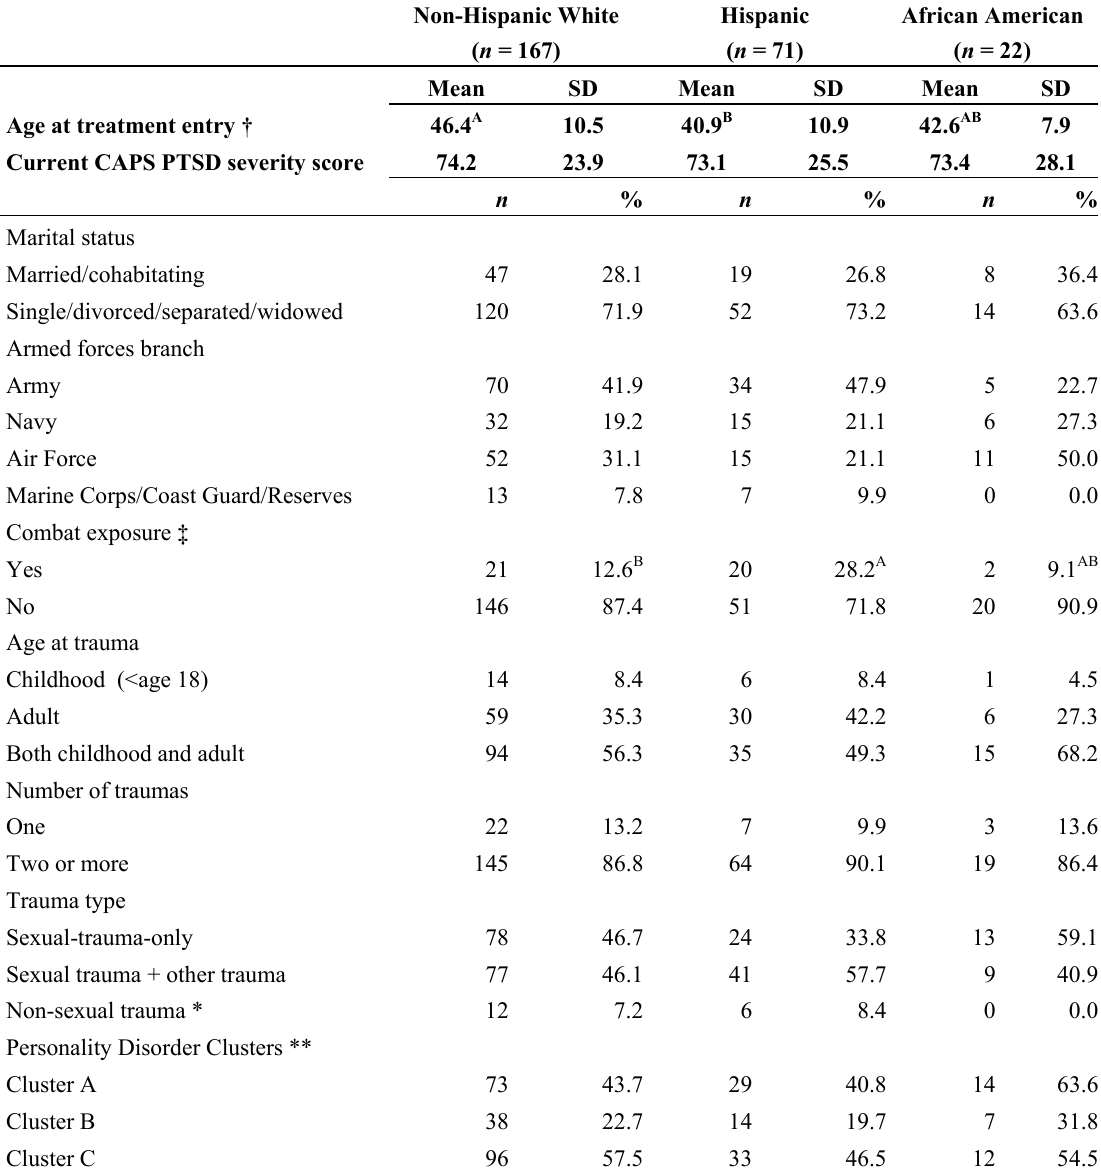
Table 2. Demographic and covariate characteristics by ethnicity in a group of women veterans diagnosed with Post Traumatic Stress Disorder (PTSD). Non-Hispanic